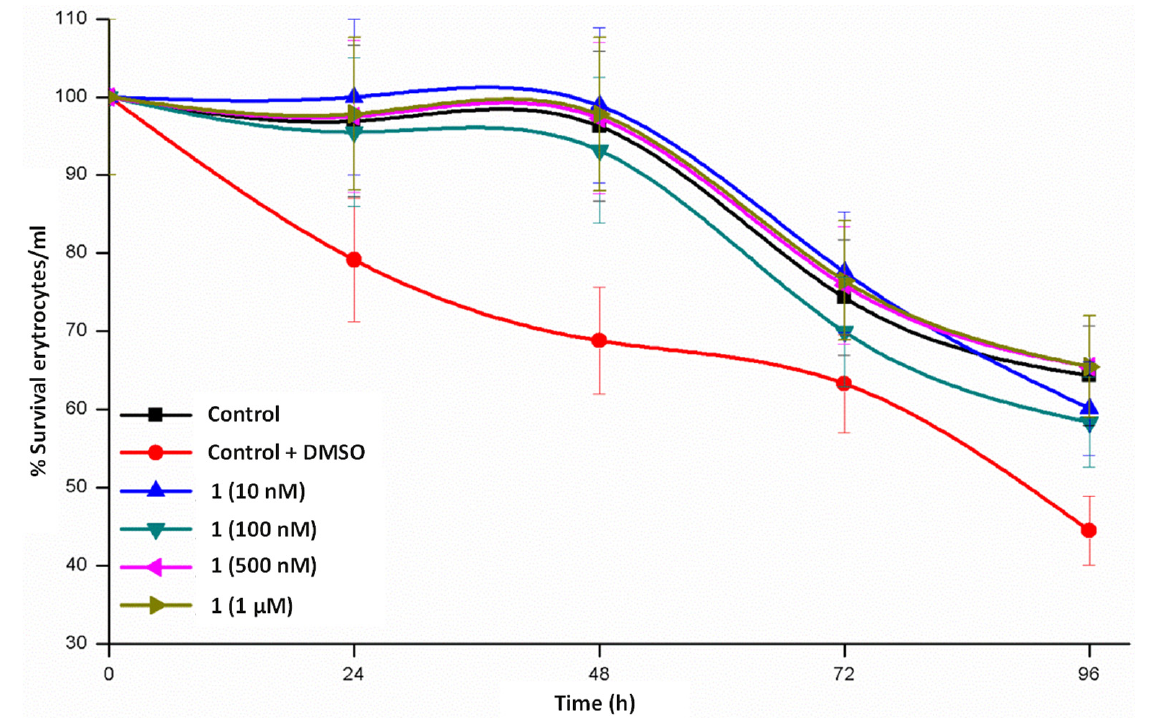
Figure 4. Time course study of erythrocyte survival in the presence of Zn 2 (L Me ) 2 · 2H 2 O 1 dihelicate.